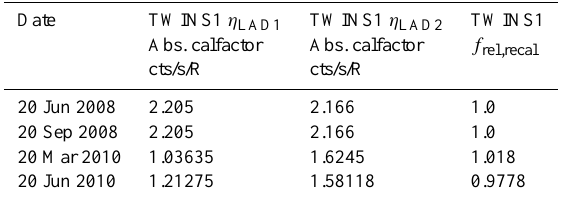
Table 3. TWINS2-LAD (absolute and relative f rel,recal ) effectivity calibration factors, newly calibrated for 2008 to